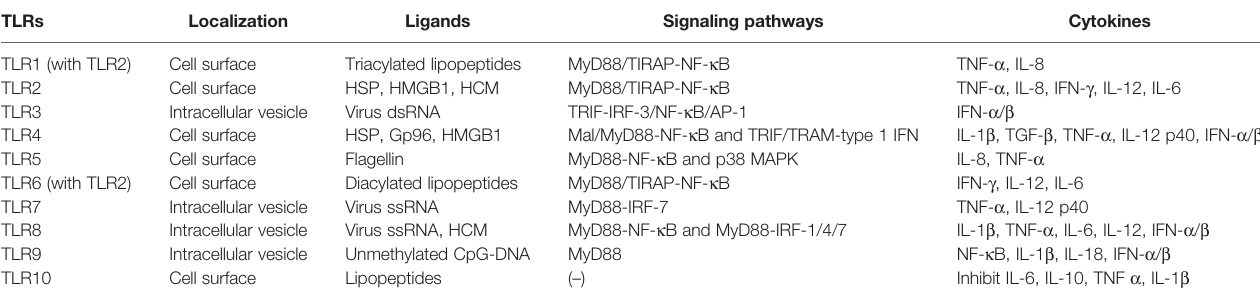
TABLE 1 | Characteristics of